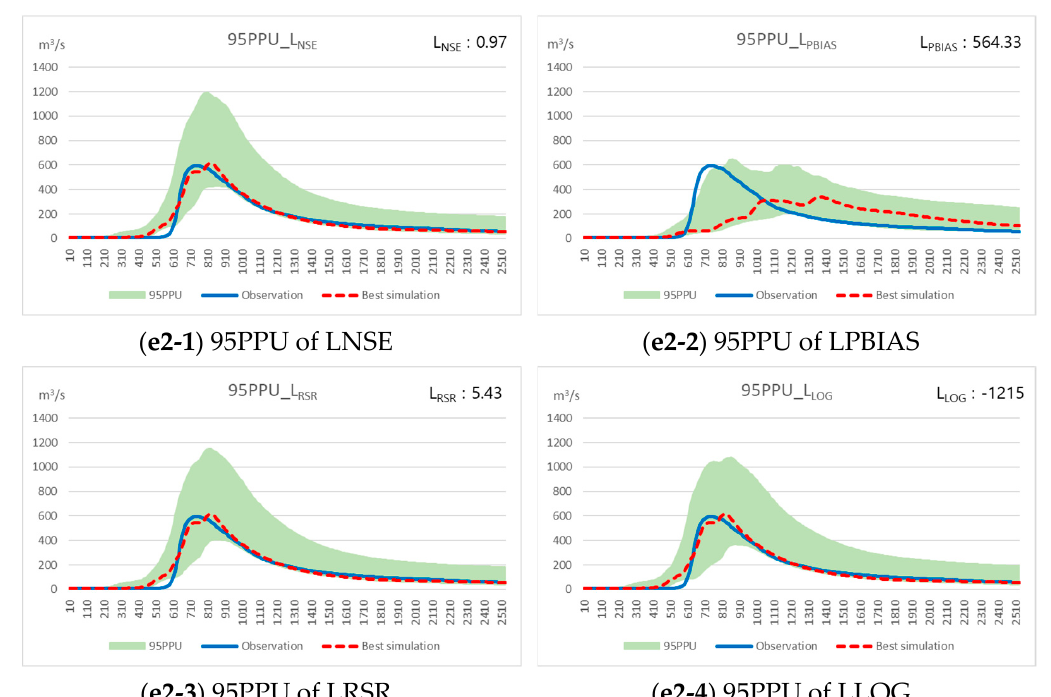
Figure 10. Event 2 95PPU. ( e2-1 ) LNSE results; ( e2-2 ) LPBIAS results; ( e2-3 ) LRSR results; ( e2-4 ) LLOG results.